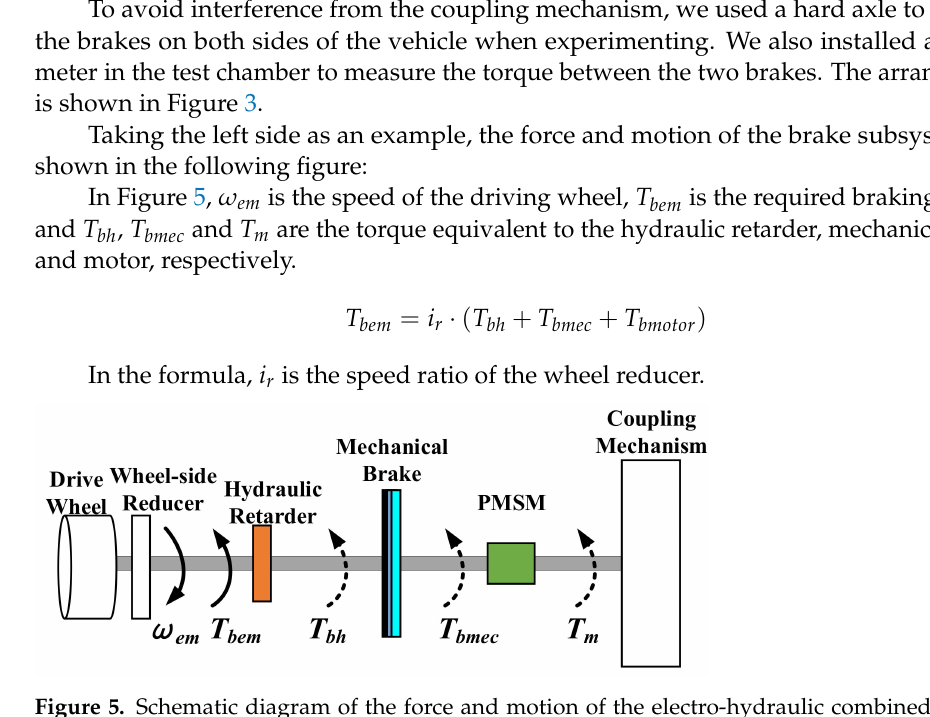
Figure 5. Schematic diagram of the force and motion of the electro-hydraulic combined braking system on the